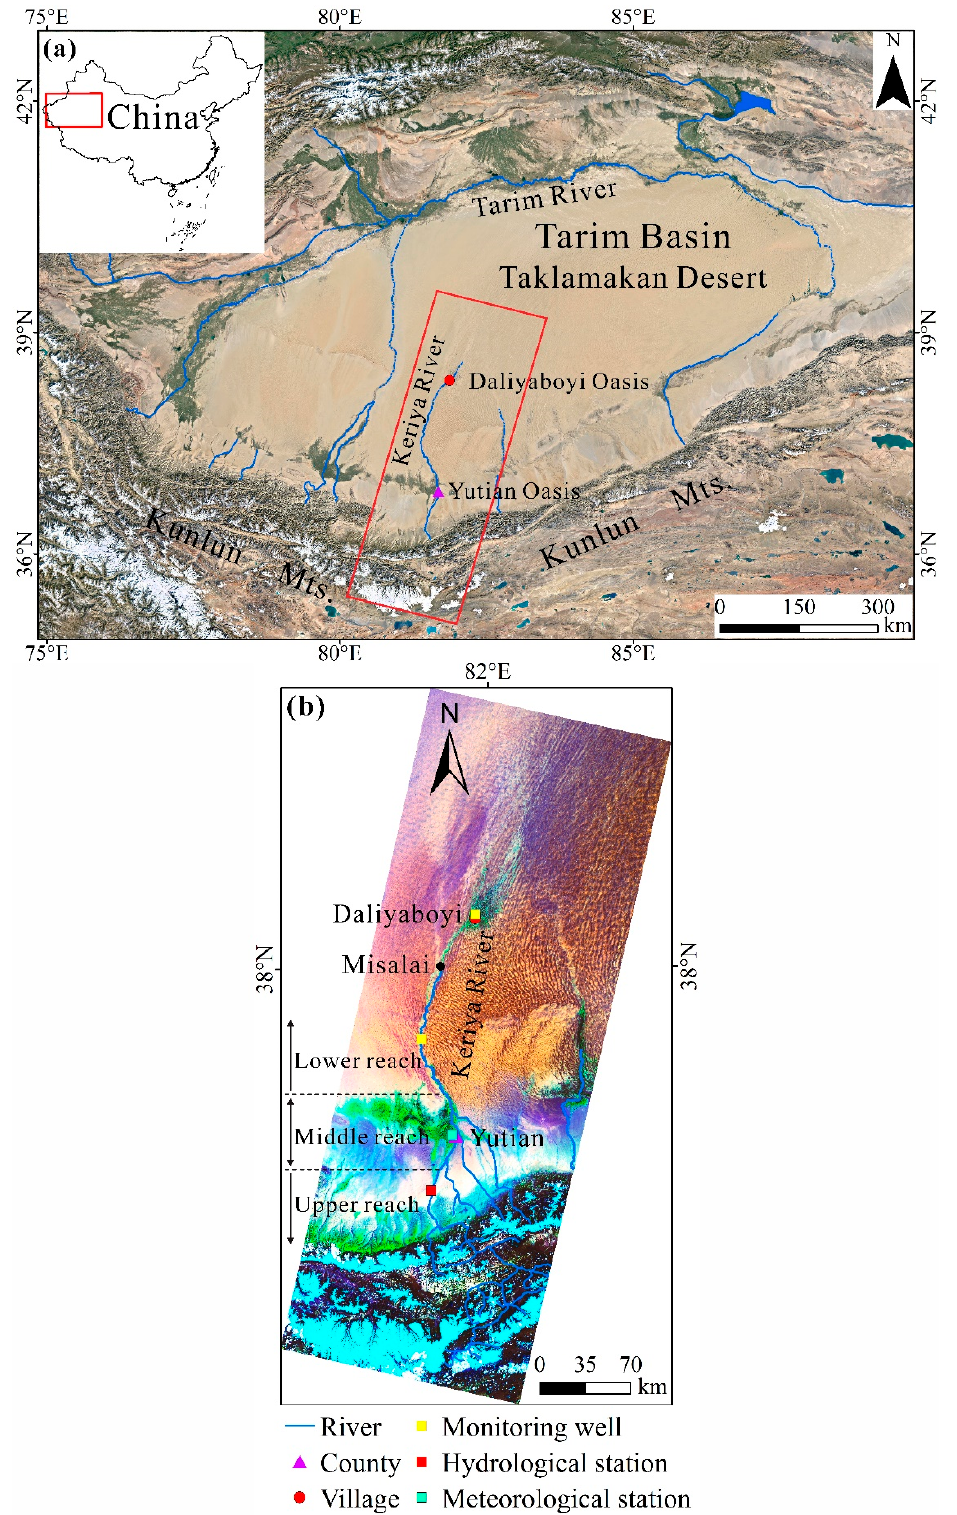
Figure 1. Location of the study area within the Tarim Basin, China. ( a ) Google Earth image in the Tarim Basin. The map of China was obtained from the website http://bzdt.ch.mnr.gov.cn/ (accessed on 1 January 2019), and the grant number is GS(2020)3183 [57]. ( b ) The imagery was processed from Landsat 8 operational land imager (OLI) data from 15 June 2016 (band composite is Red (7), Green (5), and Blue (2)) [57], showing the location of the Keriya River